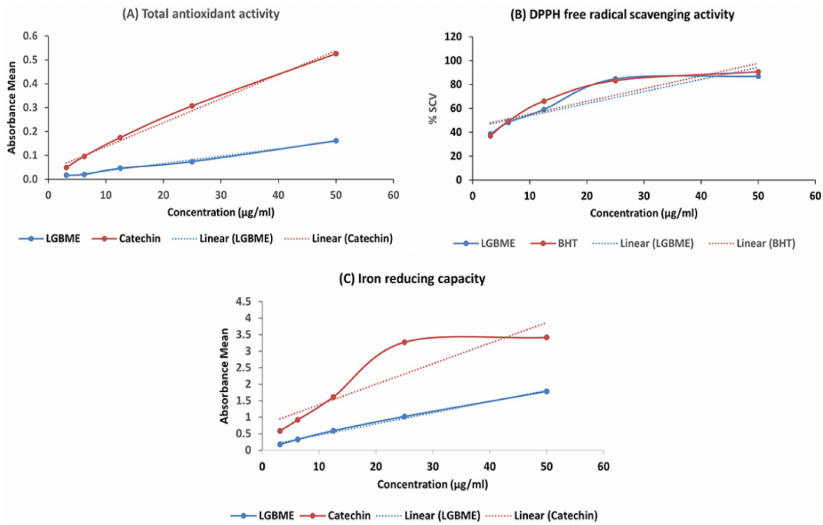
Figure 2. Antioxidant activity of LGBME. ( A ) Total antioxidant activity of LGBME and catechin; ( B ) DPPH free-radical-scavenging activity of LGBME and BHT; ( C ) iron-reducing capacity of LGBME and